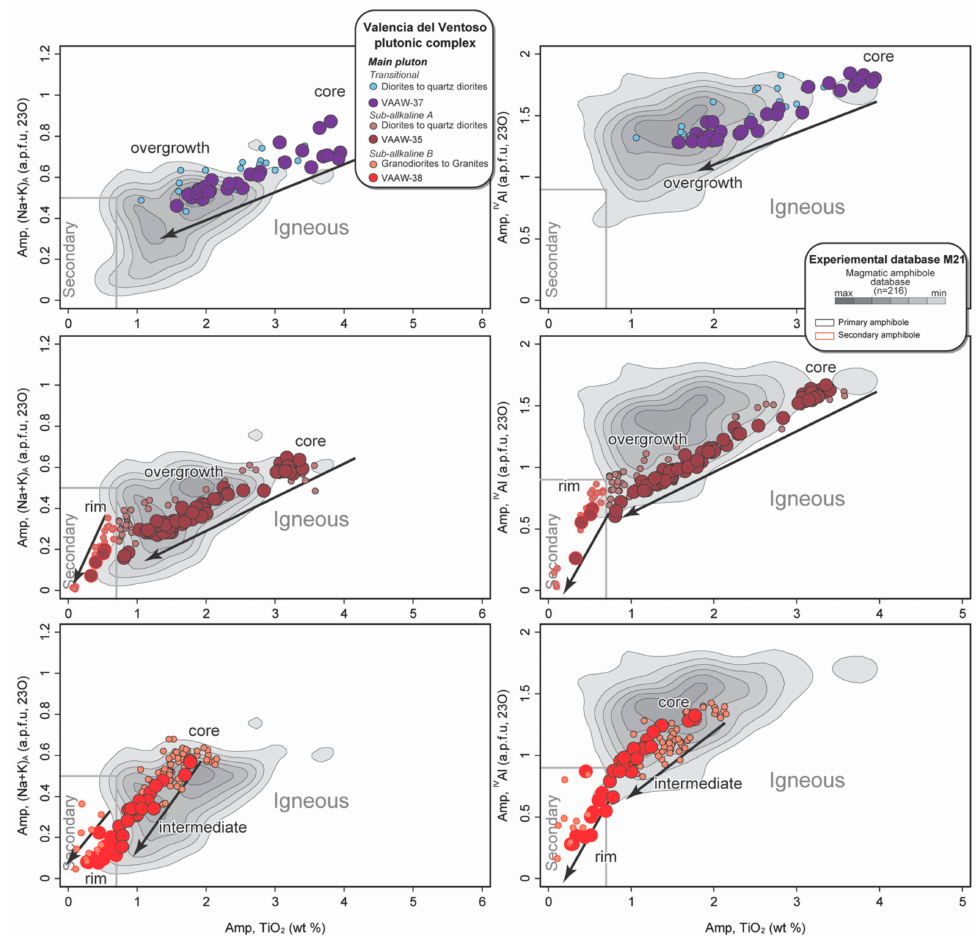
Figure 8. Composition of amphibole from intermediate and border facies rocks from the Valencia del Ventoso main pluton. Na A + K (apfu) versus TiO 2 (wt.%) and Al IV (apfu) versus TiO 2 (wt.%). Also shown are bivariate kernel density estimations after [51] of compositional data of synthetic supersolidus amphibole compiled by [16]. The diagrams show a well-defined compositional field for magmatic amphibole thus permitting a discrimination between secondary and primary amphiboles (see further discussion in [2]). The arrows represent the main compositional trends of amphibole compositions. Compositional data of amphibole from [44] (smaller lighter symbols) are shown for